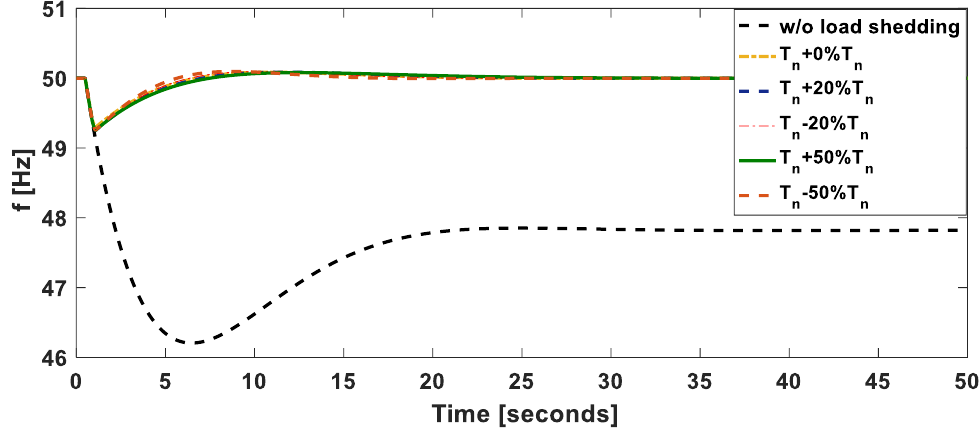
Figure 16. Frequency behavior of the proposed UFLS technique under uncertainties in determining the constant time of the governor-turbine system, T, in SFR model.